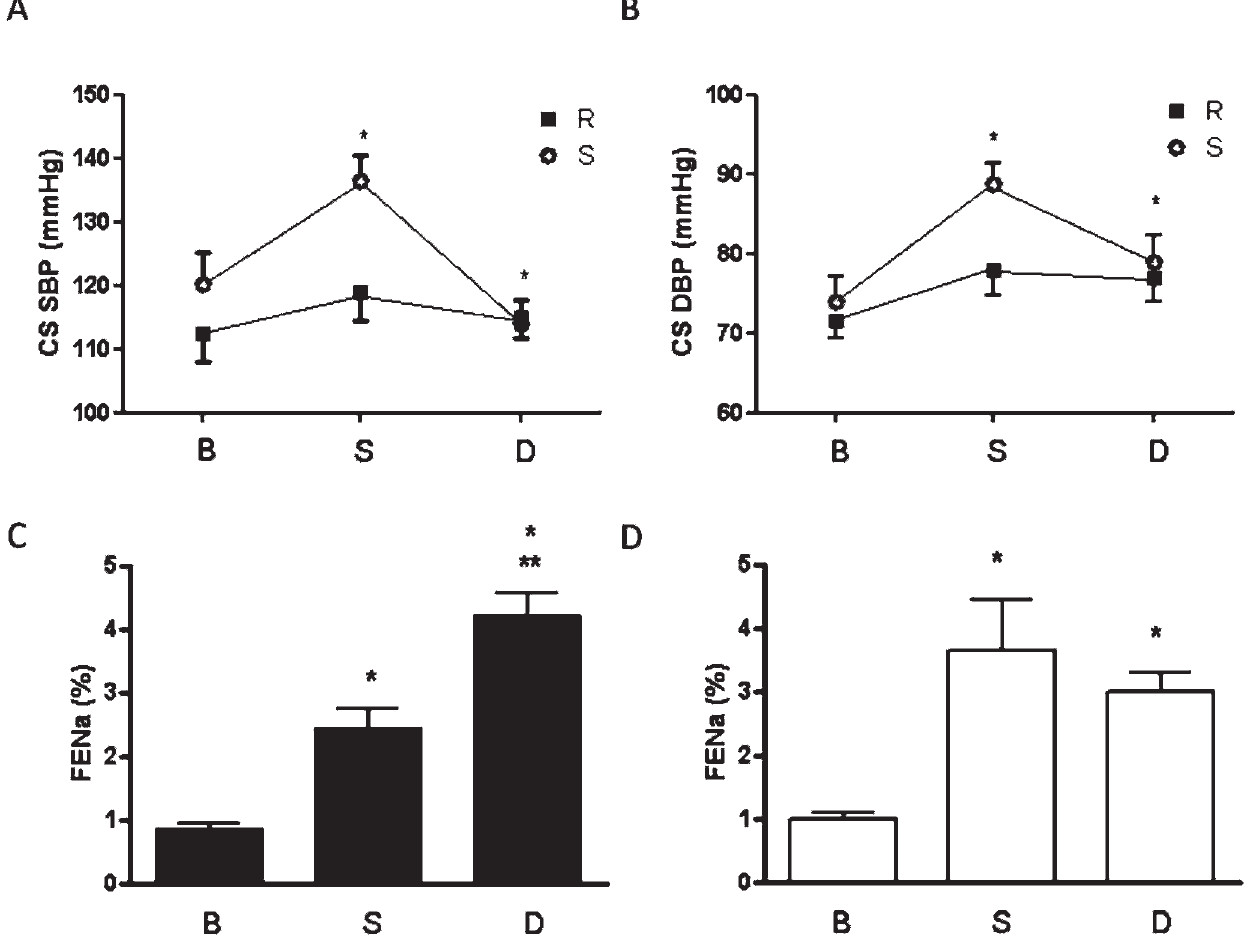
Figure 1 - CS SBP (A, upper panel left) and DBP (B, upper panel right) during the baseline (B) and periods of salt loading (S) and depletion (D). There was a significant increase in BP with salt loading (P , 0.05) and a decrease in BP with furosemide-induced salt depletion (P , 0.05) only in the S group. The lower panel shows FENa at baseline (B) and during periods of salt loading (S) and depletion (D) for the R group (black bars, C) and S group (white bars, D). Data are expressed as means ¡ SE; * = P , 0.01 vs. baseline; ** P , 0.05 S vs.